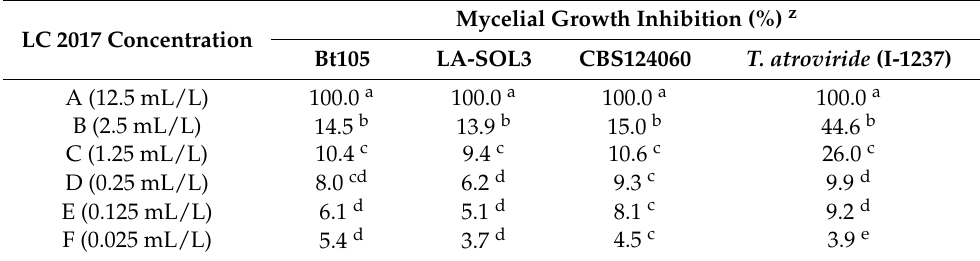
Table 1. Mycelial growth inhibition rate (%) of product LC2017 on all the Botryosphaeriaceae isolates under study (Bt105, LA-SOL3, CBS124060) and the Trichoderma atroviride strain I-1237